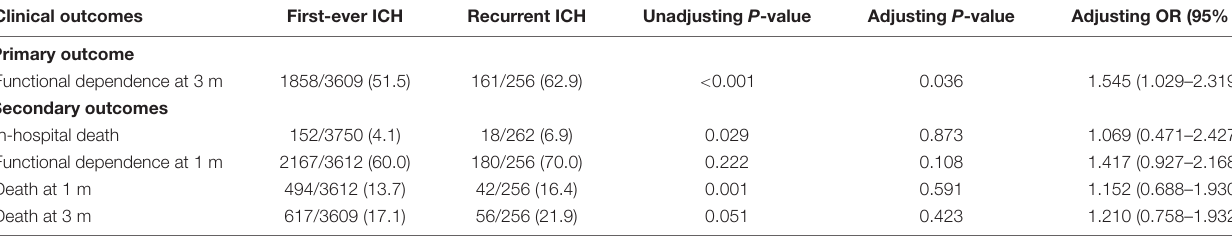
TABLE 2 | Odds ratio (OR) and 95% CI of Clinical